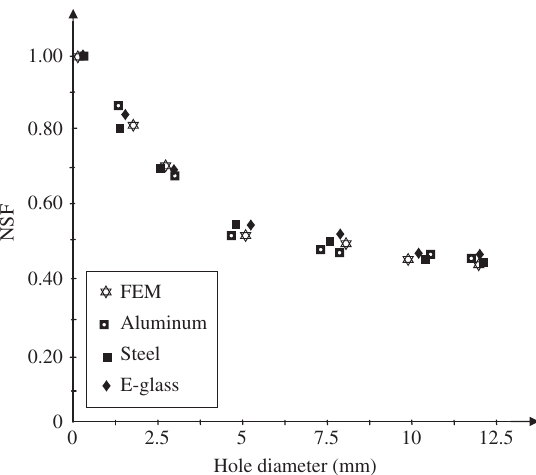
Figure 4 Comparison of NSF in compression for unbonded reinforcements.